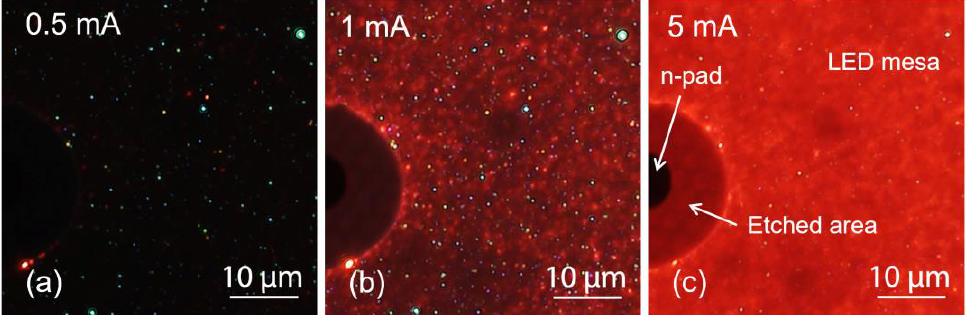
Figure 4. EL mappings at the current of ( a ) 0.5 mA, ( b ) 1 mA and ( c ) 5